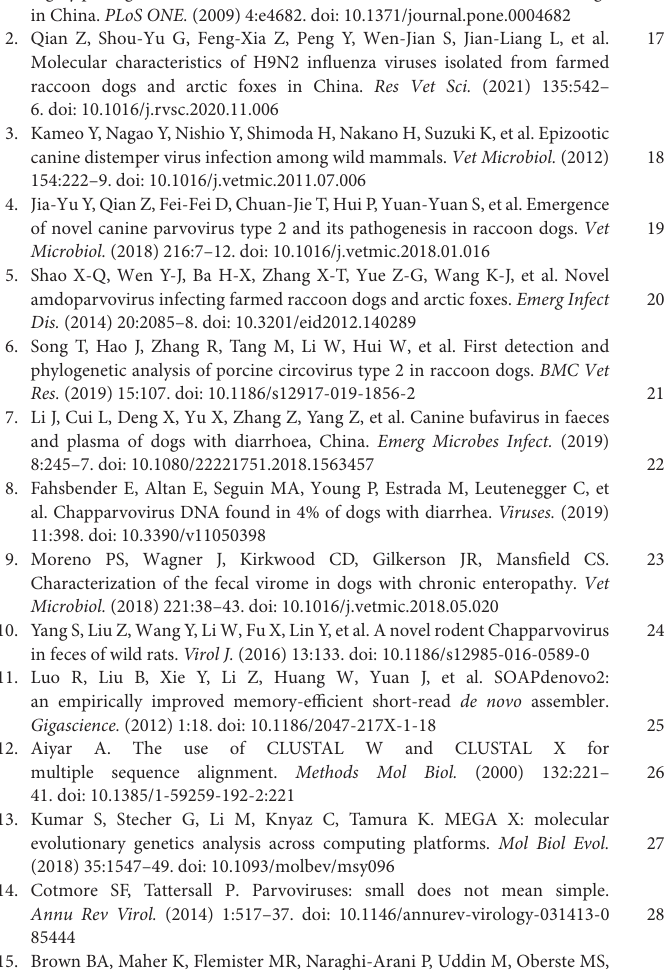
species was generated with Weblogo 3. Four walker domains were marked with square boxes.